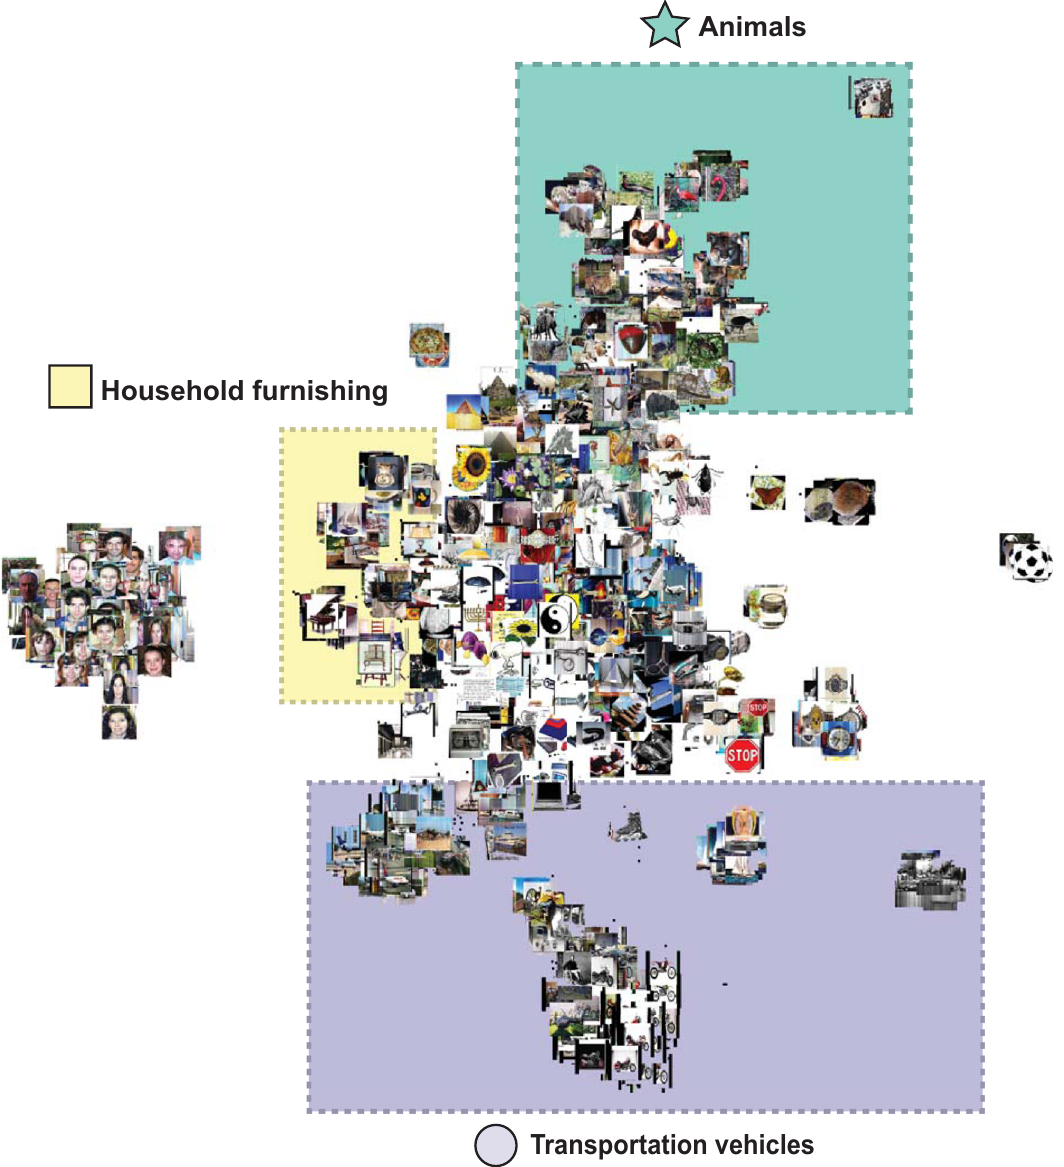
Fig. 2 UMAP representation of Caltech 101 dataset. The hyperparameters for the UMAP were n_neighbors = 5, min_dist = 0.3, n_components = 2, metric = “ correlation ”